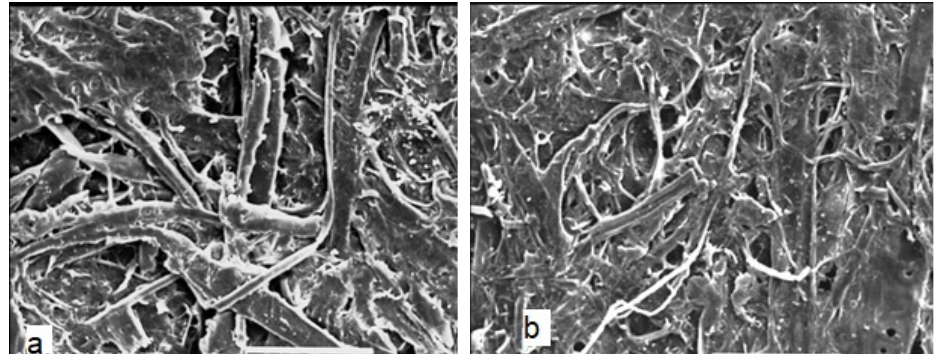
Figure 6. Images of the surface of a sheet of handwritten paper book obtained on an electronic scan-